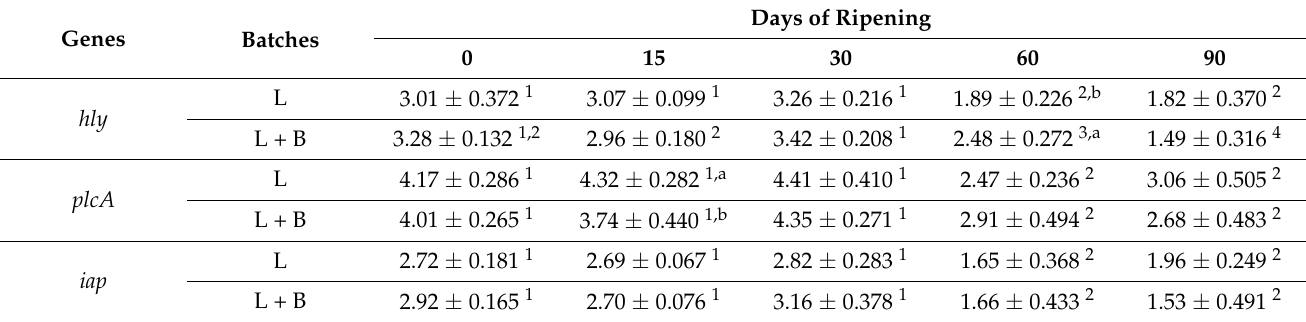
Table 1. Absolute expression values (mean log copies of gene ± standard deviation) of the virulence ( plcA , hly , and iap ) genes of Listeria monocytogenes in dry-cured fermented sausages “salchich ó n” throughout the ripening process. Batches: